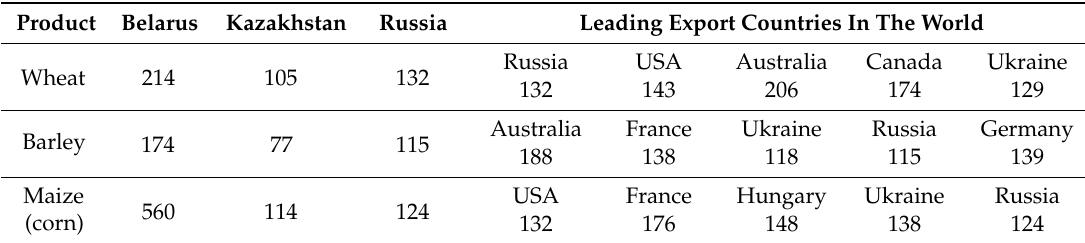
Table 8. Average producer prices for agricultural products in the EAEU and the leading export countries in the world in 2016, USD